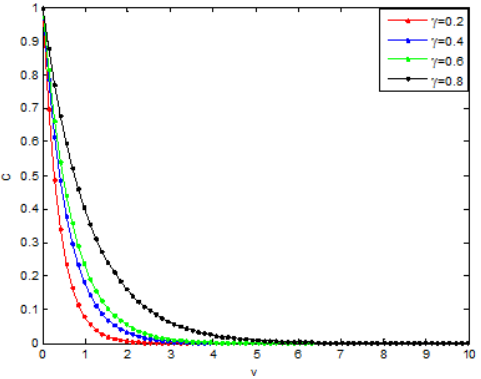
Figure 5. Effects of Casson parameter on concentration profile Of the Casson